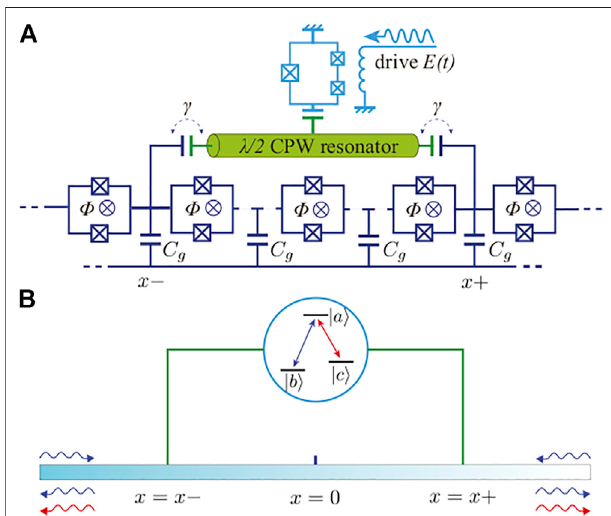
FIGURE 1 | (A) Sketch of the circuit, a SQUID-chain waveguide (deep blue) capacitively coupled to a giant atom consisting of a fl ux qubit and a λ /2 CPW resonator at x ± two points, γ denoting coupling strength. (B) Schematic illustration of the whole system. The giant atom is Λ -type three-level system consisting of exicting state | a 〉 , ground state | b 〉 and substable state | c 〉